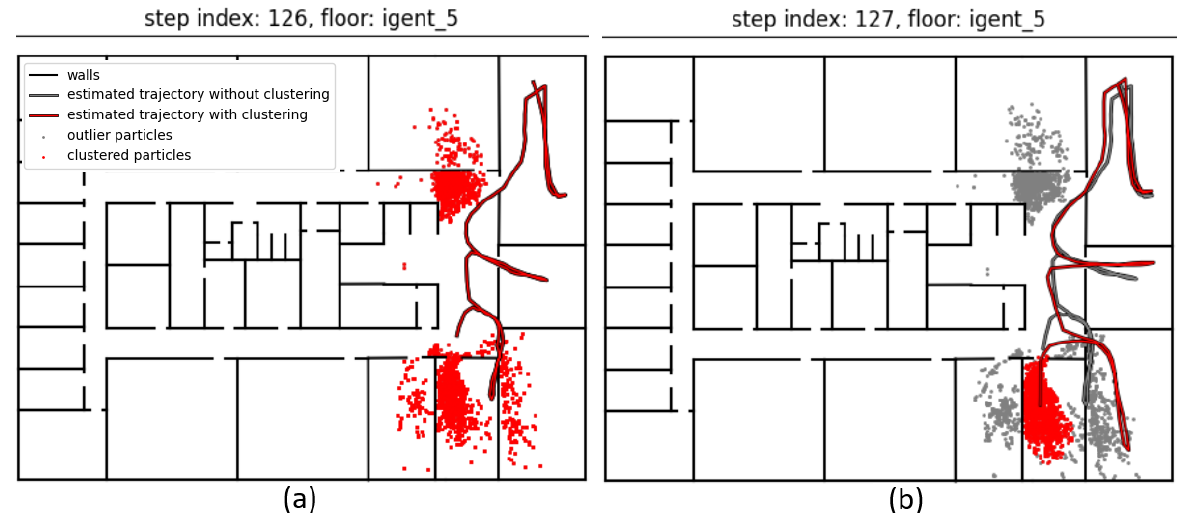
Figure 5. No significantly heavy cluster was found ( a ); thus the new position was calculated by averaging all particles. One step later ( b ), the correct cluster became heavier and was recognized by the clustering algorithm. The new position was calculated by averaging only the clustered (red)